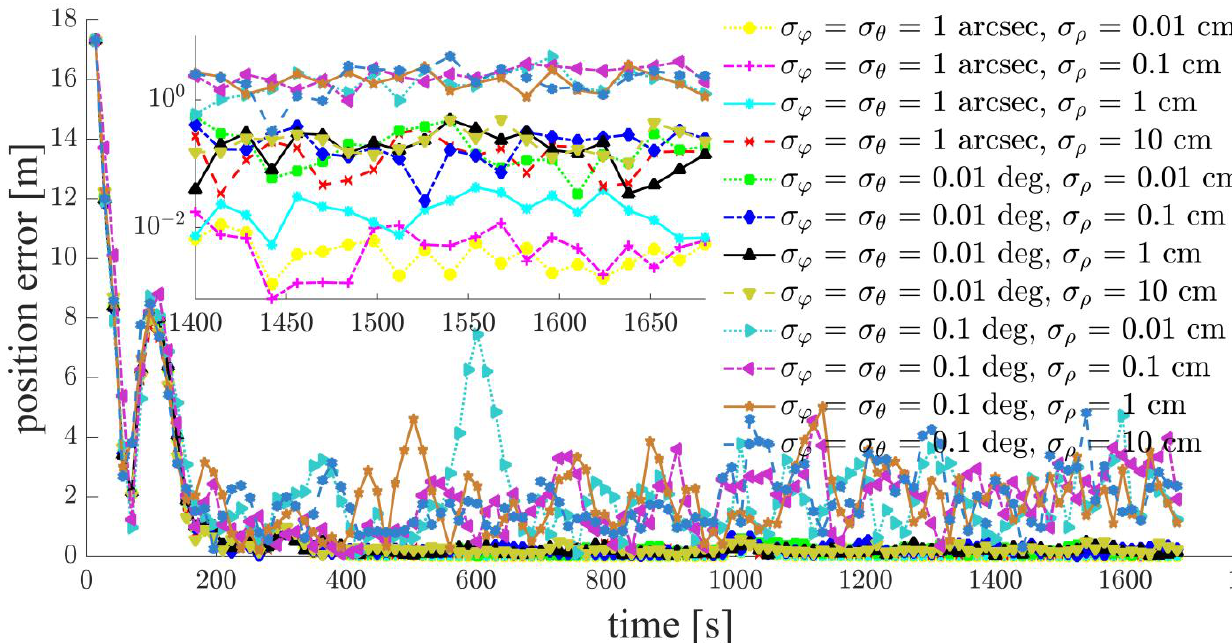
Figure 12. Relative navigation errors of 𝑆 2 (simulated scenario: Case d, space-circle formation radius of 1 km).